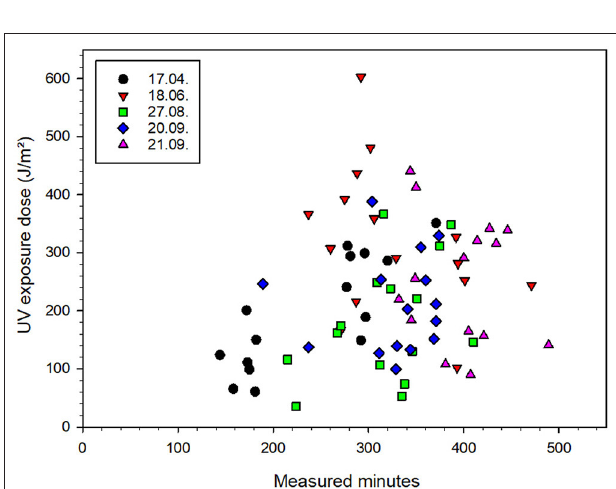
FIGURE 5 | UV exposure doses and total measured minutes for all participants of the “visiting parks” activity. The different measurement days are color coded, with 15 participants for each day. Each participant represents one data point. As an example, the red triangle on top represents a participant who took part on 18 th of June, wore the dosimeter for 292min and received an exposure dose of 603 J/m ²